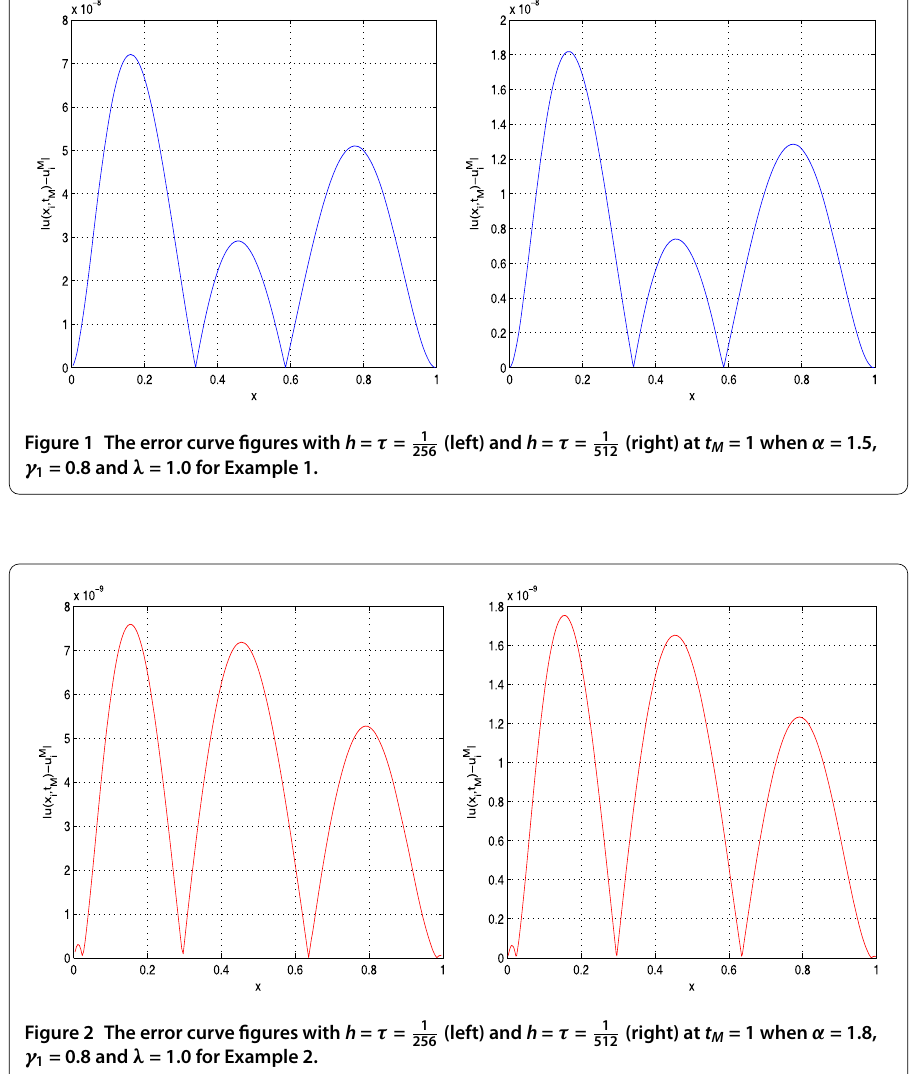
Figure 2 The error curve figures with h = τ = 1 γ 1 = 0.8 and λ = 1.0 for Example